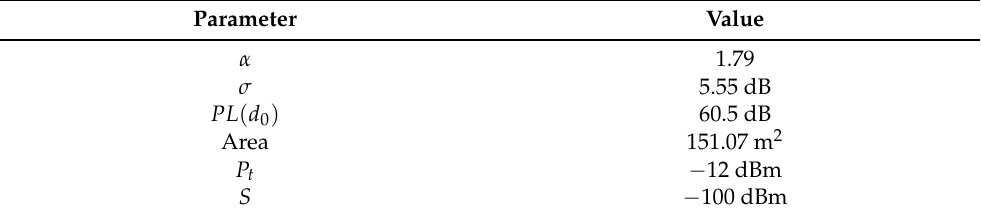
Table 4. Environment parameters for the Geotec room.